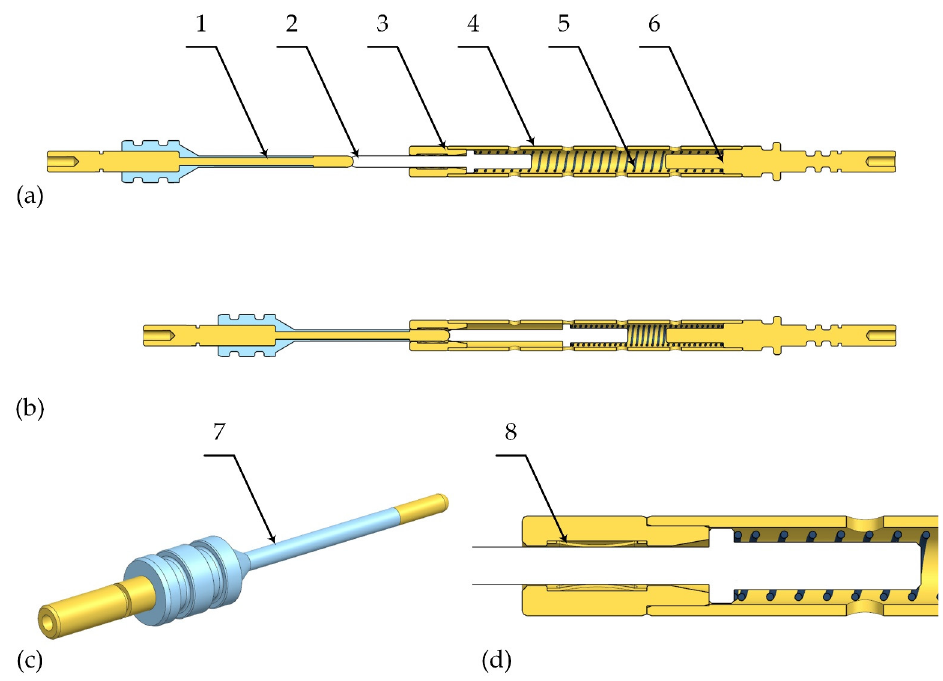
Figure 5. A schematic illustration of the shuttle pin design in ( a ) the disconnecting state and ( b ) the connecting state, and the detail views of ( c ) the contact pin and ( d ) the electric socket: 1-contact pin; 2-moveable stopper; 3-electric socket; 4-conductive sleeve; 5-spring; 6-conductive shaft; 7-insulating layer; 8-crown